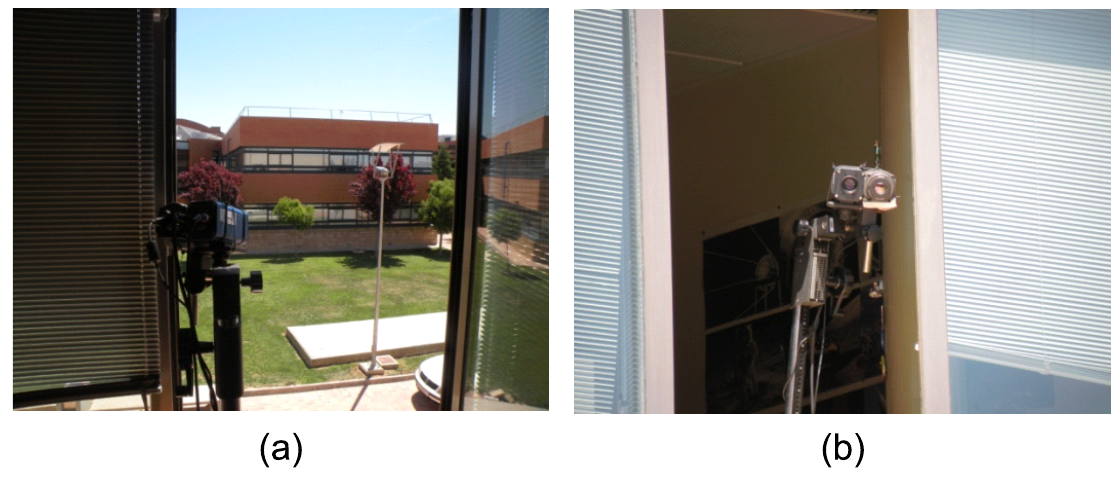
Figure 6. Installation for simultaneous acquisition on the thermal infrared and visible-light spectra. ( a ) Back view; ( b ) front